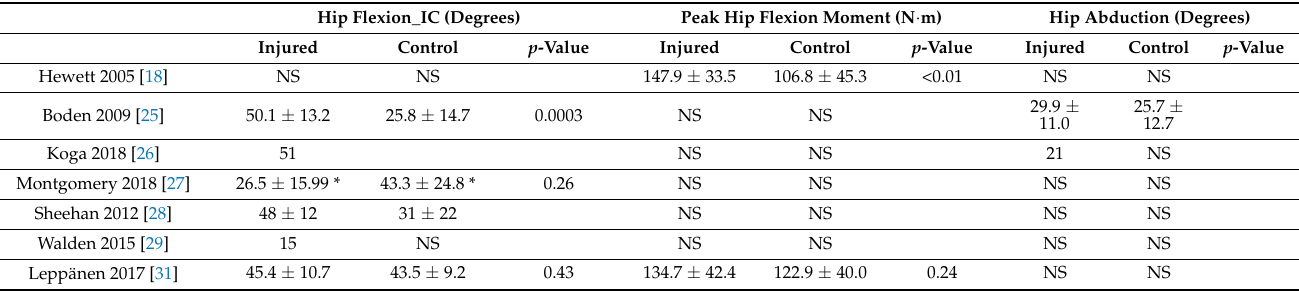
Table 2. Hip Angle Variables Reported by Studies